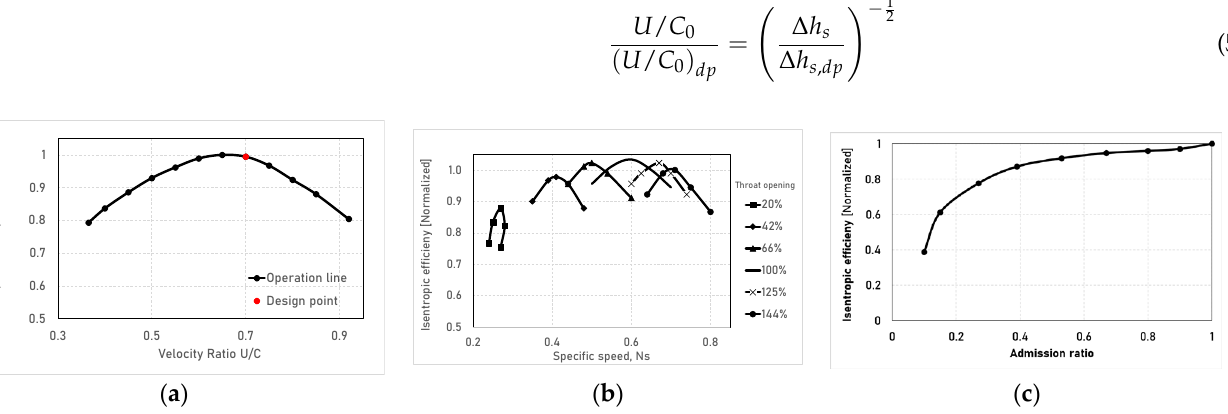
Figure 3. Turbine isentropic efficiency: ( a ) Fixed geometry; ( b ) VAN; ( c ) Partial admission.